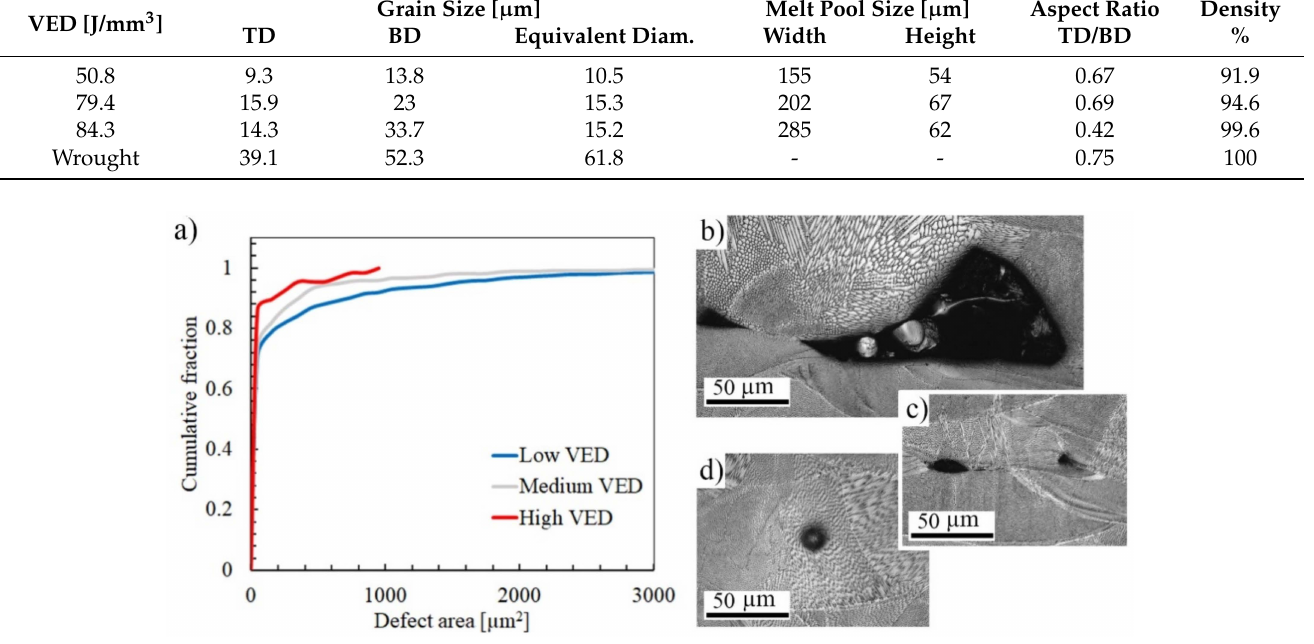
Figure 4. ( a ) Defect size distributions as cumulative fractions in L-PBF AISI 316L and ( b ) typical large lack-of-fusion type void. ( c ) Lack of fusion defect with sharp characteristics and ( d ) a round pore formed by gas